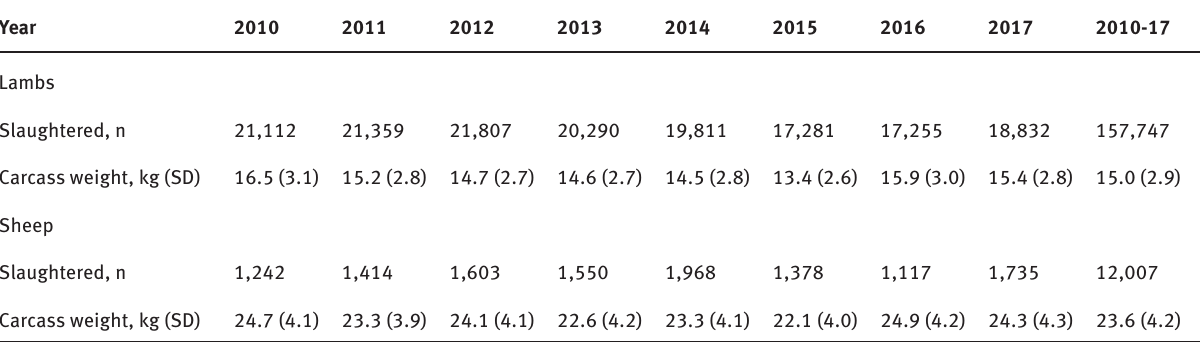
Table 1: Number of slaughtered lambs and sheep and their carcass weight